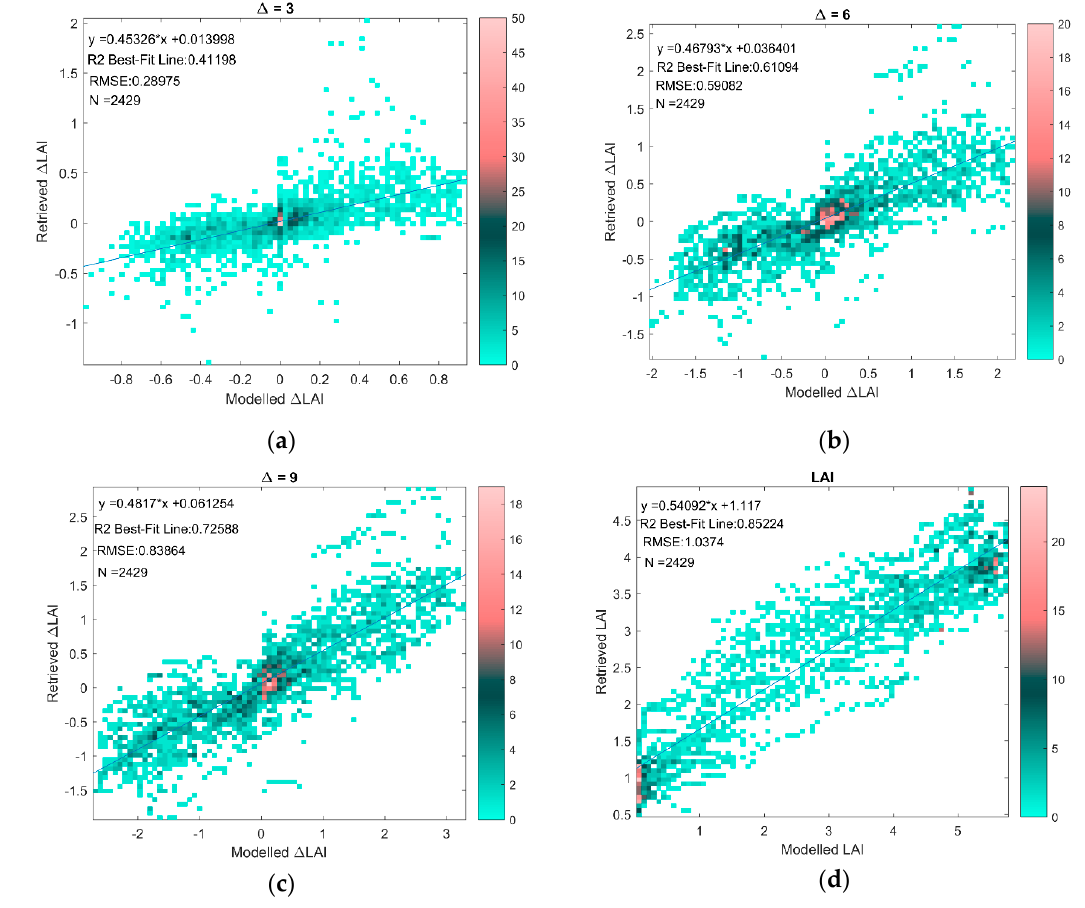
Figure 6. ( a – c ) Retrieved versus HM Modeled Δ LAI at Δ = 3, 6, 9; ( d ) Retrieved versus HM Modeled LAI. The colorbars represents the number of points at each marker on the scatter plot.